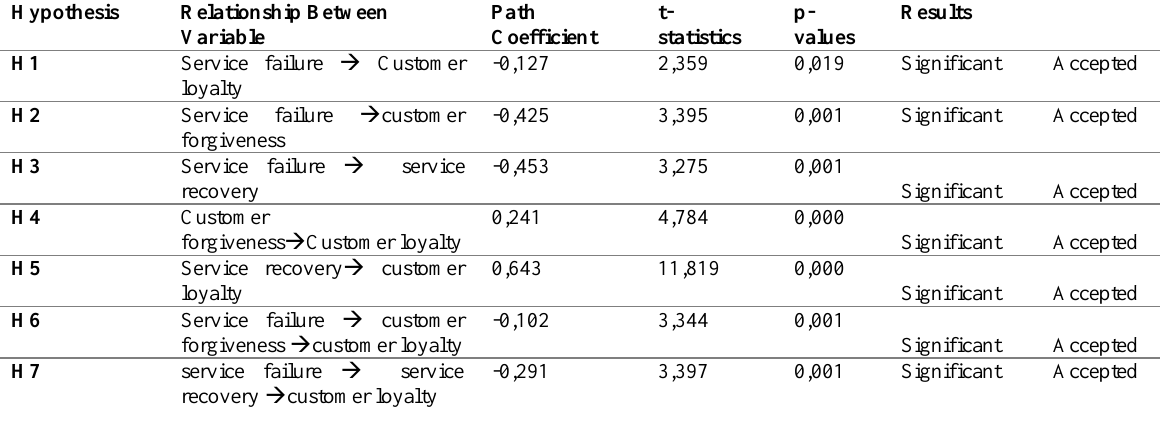
Table 2 : Hypothesis Testing